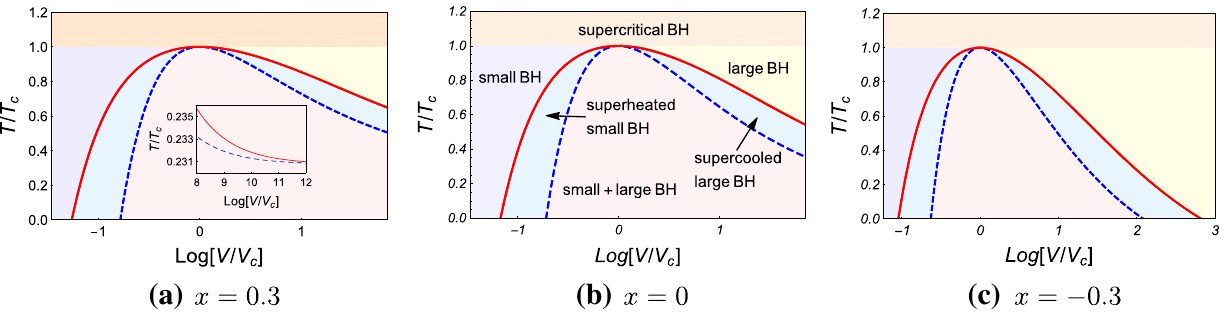
yellow, green and pink describe the supercritical black hole, small black hole, large black hole, metastable phases (superheated small black hole and supercooled large black hole), small/large black hole coexistence phase,